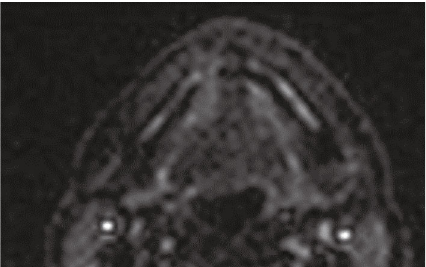
Figure 5: Magnetic resonance imaging, horizontal cross section, short T1 inversion recovery. There are no signs of tumors or in fl